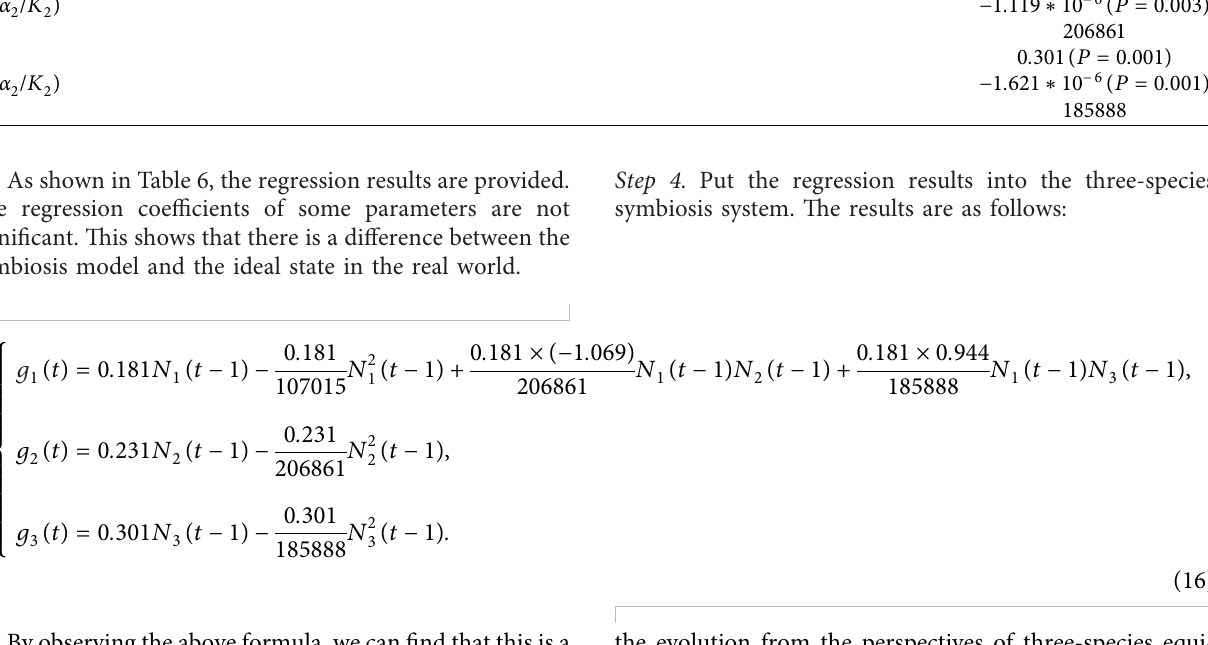
Table 5: Calculation results of α